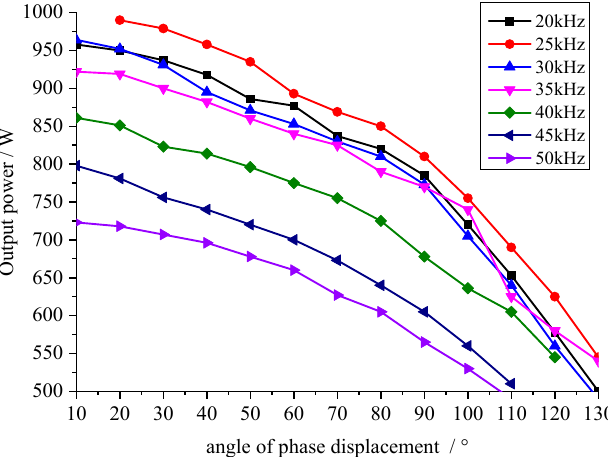
Figure 21. Diagram of the relationship between output power and phase shift angle.